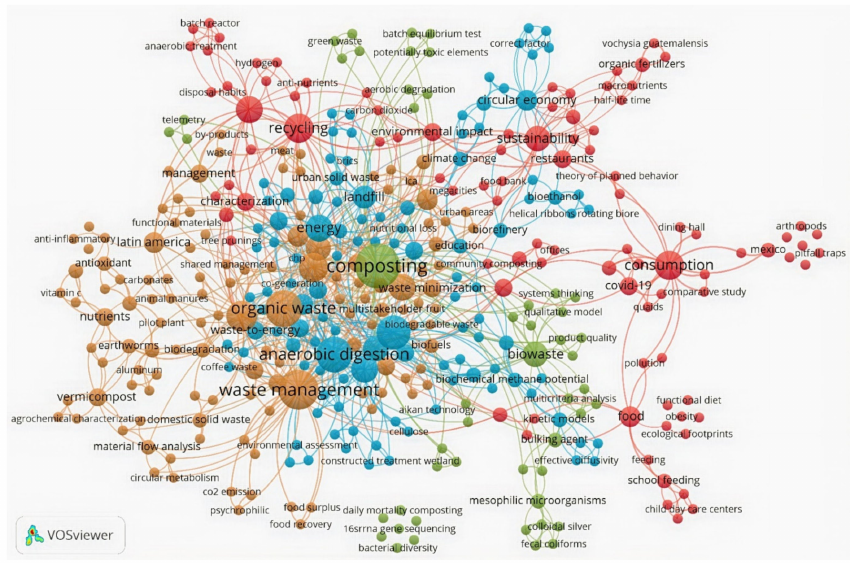
Figure 3. Scopus keywords co-occurrence network.